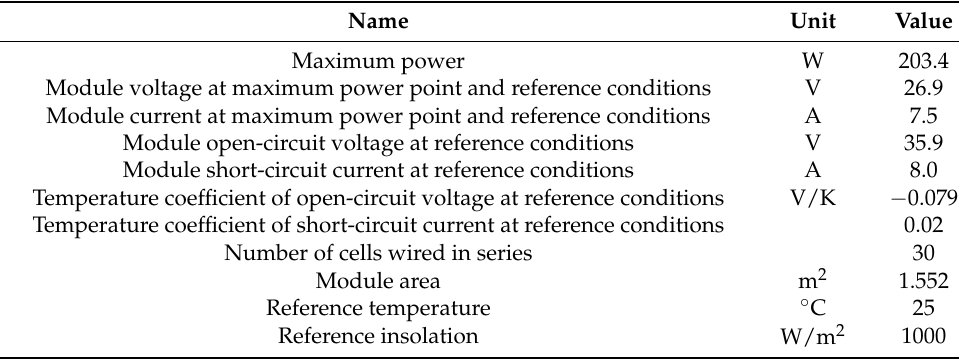
Table 1. Characteristics of the photovoltaic modules